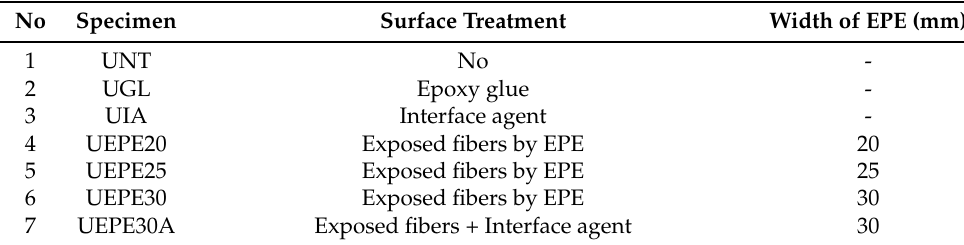
Figure 4. Interface treatments on the steamed-cured substrate. Table 6. Detailed summary of